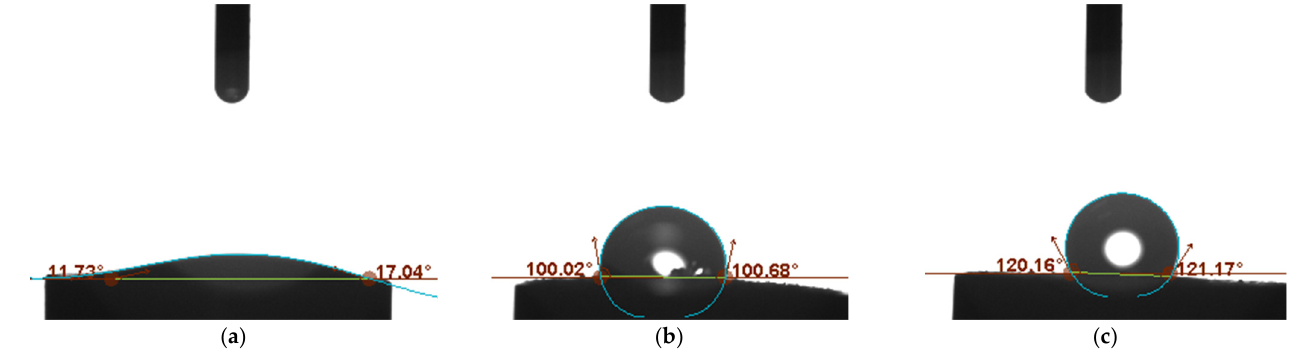
Figure 2. Contact angles of the studied materials: ( a ) hydrous cerium dioxide, ( b ) hydrous cerium dioxide—carbon nanotubes, ( c ) hydrous cerium dioxide—poly(3-octylthiophene-2,5-diyl). Unlike hydrophilic cerium dioxide (which is characterized by the contact angle of only 17°) (Figure 2a), the composite materials turned out to be superhydrophobic with the